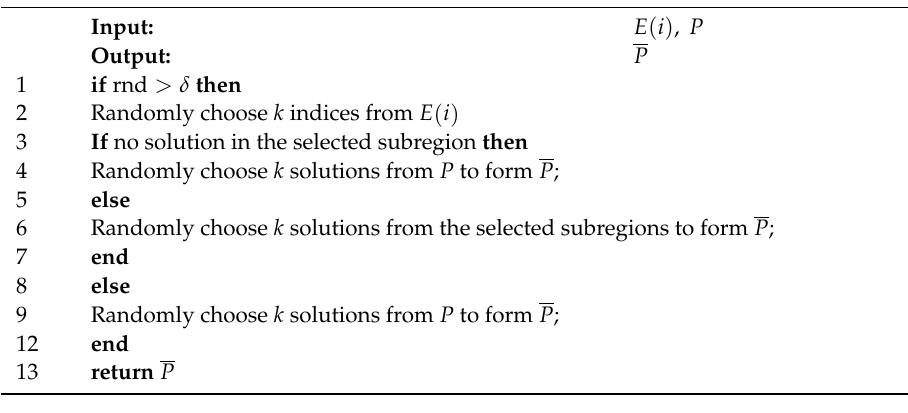
Algorithm 3: Mating Selection.